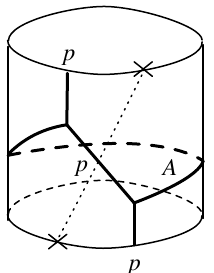
Figure 24 . The projector de(cid:12)ning the Hilbert space of the gauged theory is a speci(cid:12)c instance of an action of a wrapped line operator. The morphisms used at the trivalent vertices are those specifying the bimodule structure of p